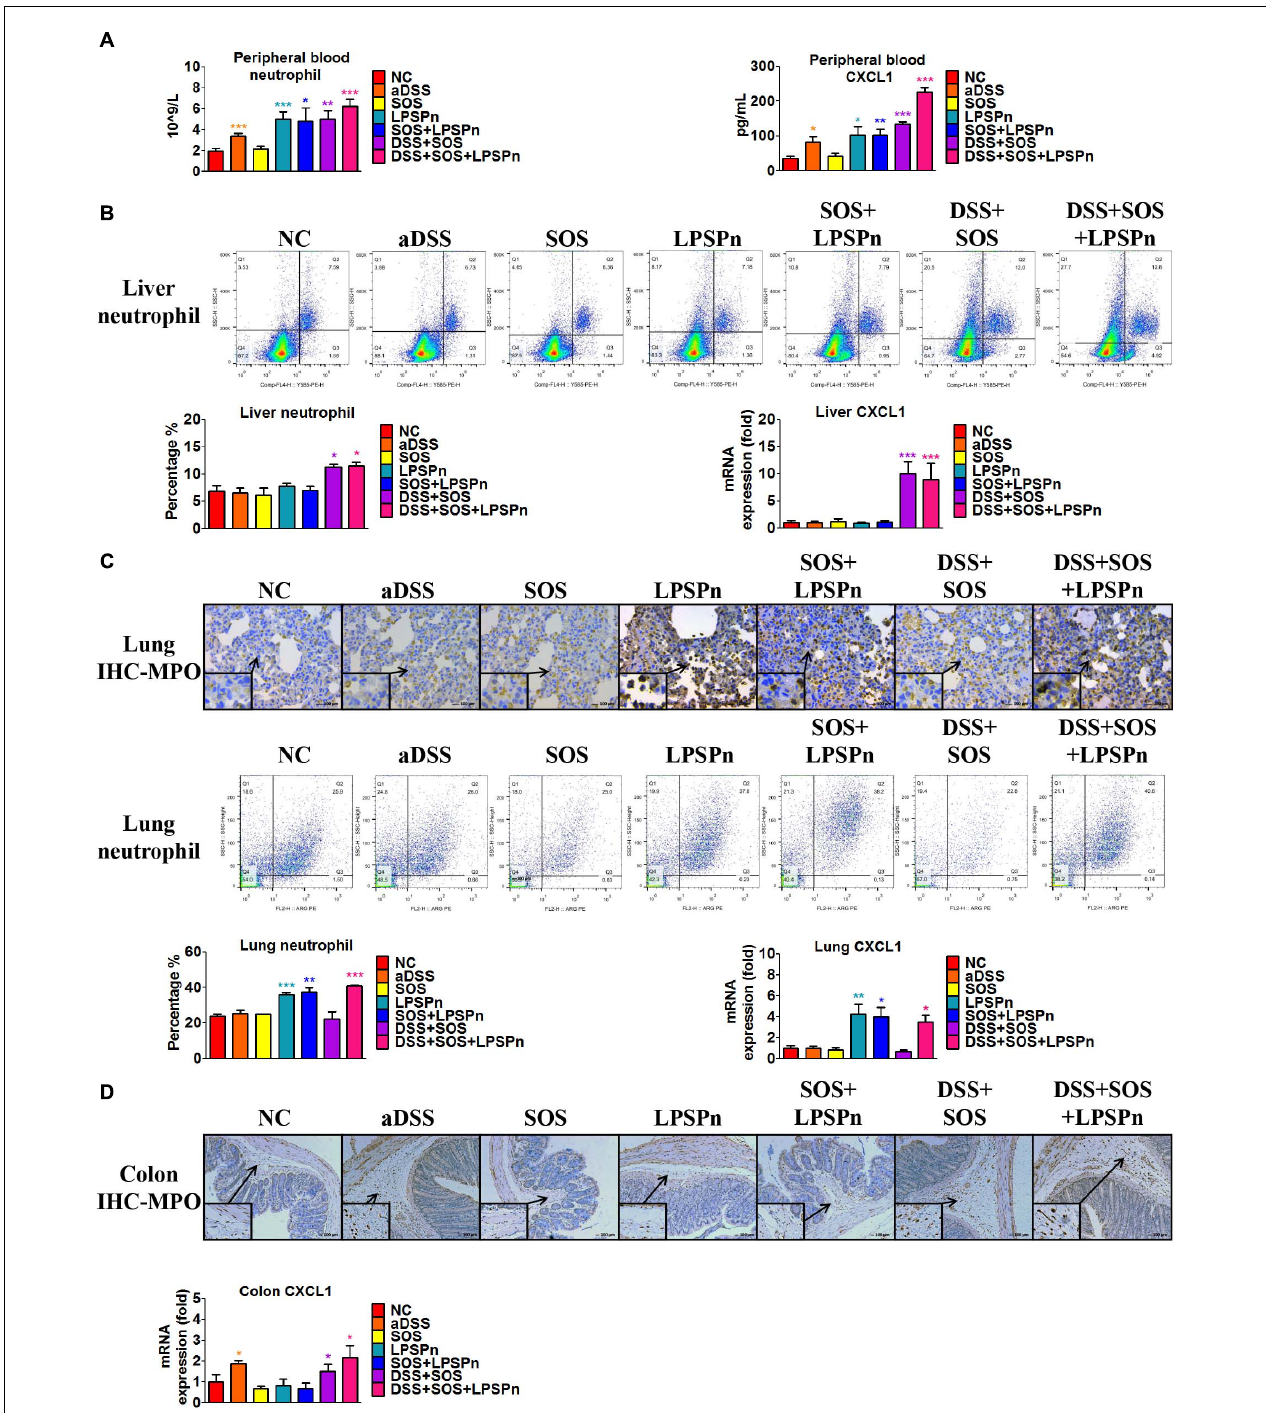
FIGURE 4 | Infiltration and accumulation of neutrophils are related with the expression of CXCL1 in various tissues. The number of neutrophils and expression of CXCL1 were evaluated at day 3 in the following seven groups: normal control (NC), acute dextran sulfate sodium colitis (aDSS), sinusoidal obstruction syndrome (SOS), lipopolysaccharide-induced pneumonia (LPSPn), SOS + LPSPn, DSS + SOS, and DSS + SOS + LPSPn. (A) In the peripheral blood, a whole blood cell test was performed and CXCL1 was tested by enzyme-linked immunosorbent assay. (B) In the liver, the number of neutrophils was evaluated by flow cytometry (anti-neutrophil + SSA high ), and mRNA level of CXCL1 was tested. (C) In the lung, immunohistochemistry for myeloperoxidase (MPO) and flow cytometry were performed and mRNA level of CXCL1 was tested. (D) In the colon, immunohistochemistry for MPO and mRNA level of CXCL1 were tested. Asterisk indicates that the level is significantly different from normal control. * p < 0.05; ** p < 0.01; *** p < 0.001 by t -test; n = 5–6 per group; figures are representative of three experiments.